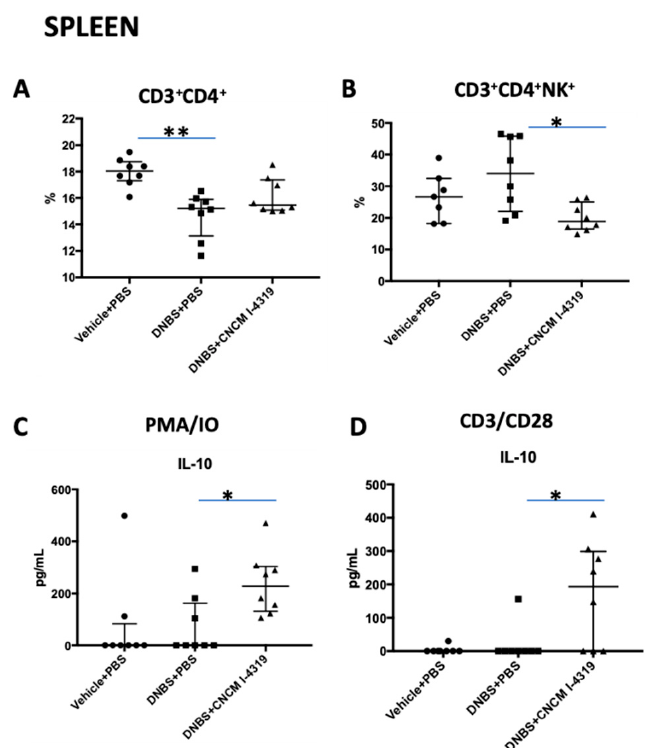
Figure 7. Splenocyte population levels in LGI model. CD3 / CD4-positive cells and subsets detected by flow cytometry ( A , B ) and cytokine production in splenocyte cultures stimulated with CD3 + / CD28 + or PMA / IO ( C , D ). Control non-inflamed (vehicle-PBS), control inflamed (DNBS-PBS), B. bifidum CNCM I-4319 strain (DNBS-CNCM-I4319). *: p < 0.05, **: p <